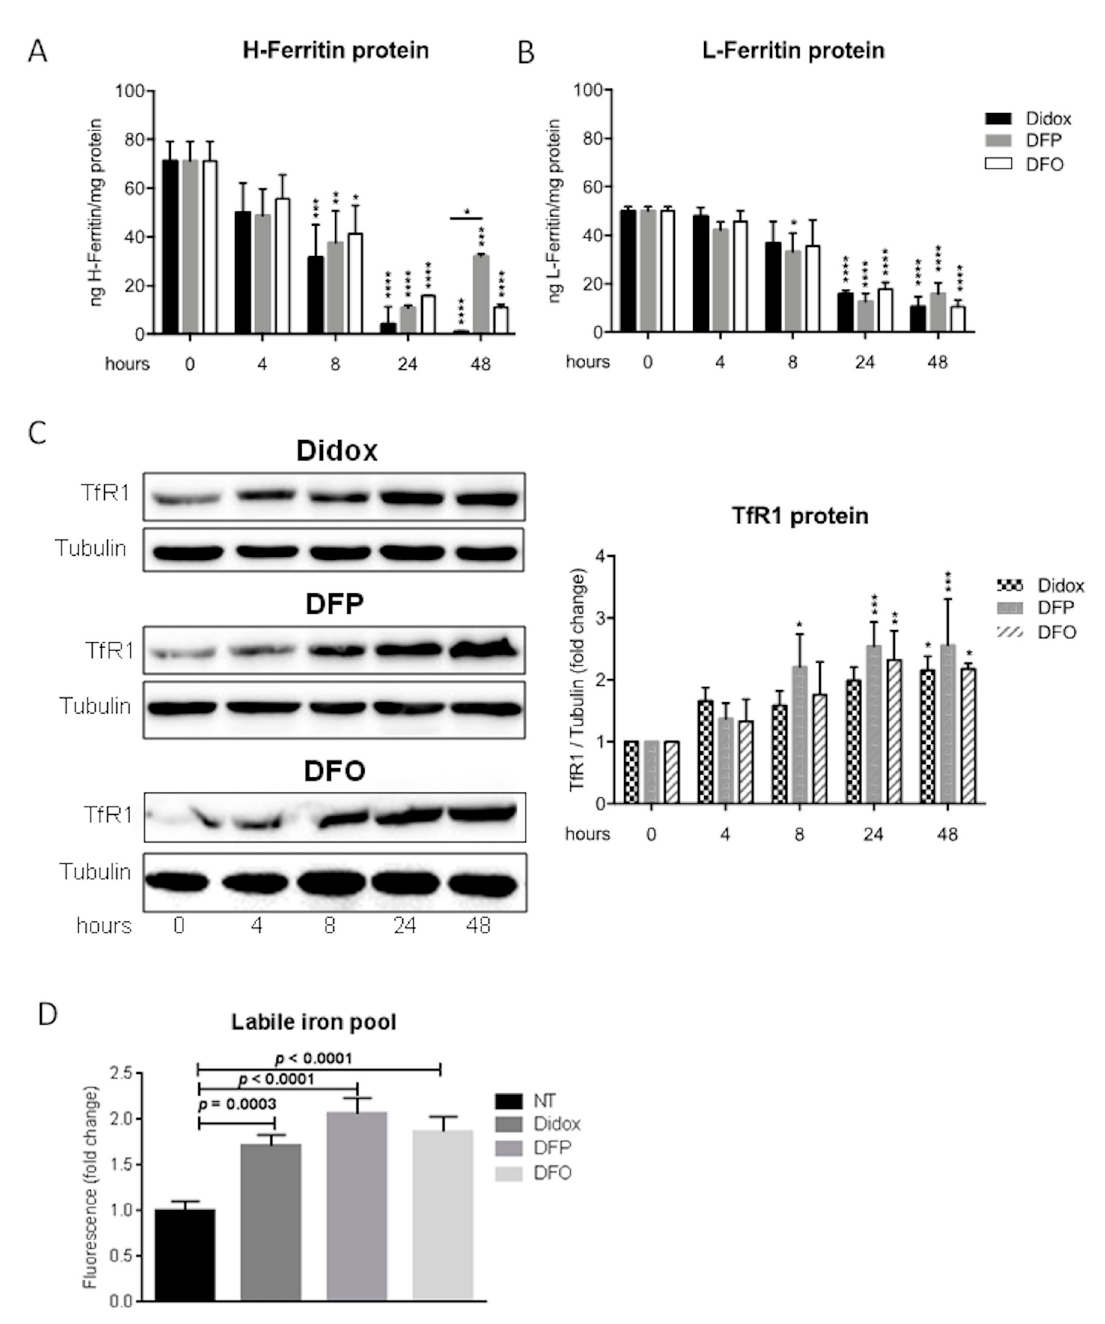
Figure 6. Didox reduced the ferritin level and labile iron pool (LIP) and induced a TfR1 increase in HA22T / VGH cells. ( A ) and ( B ) An ELISA assay for H- and L-ferritin in HA22T / VGH cells treated with didox, DFP and DFO 100 µ M at 4, 8, 24 and 48 h; ( C ) TfR1 and tubulin western blotting analysis with didox, DFO and DFP 100 µ M at 4, 8, 24 and 48 h; ( D ) calcein-AM assay in cells treated with didox, DFP and DFO 100 µ M at 4 h. The graphs are means of three independent experiments ( N = 3). p -values, showed in the graphs, were obtained by an ordinary one-way